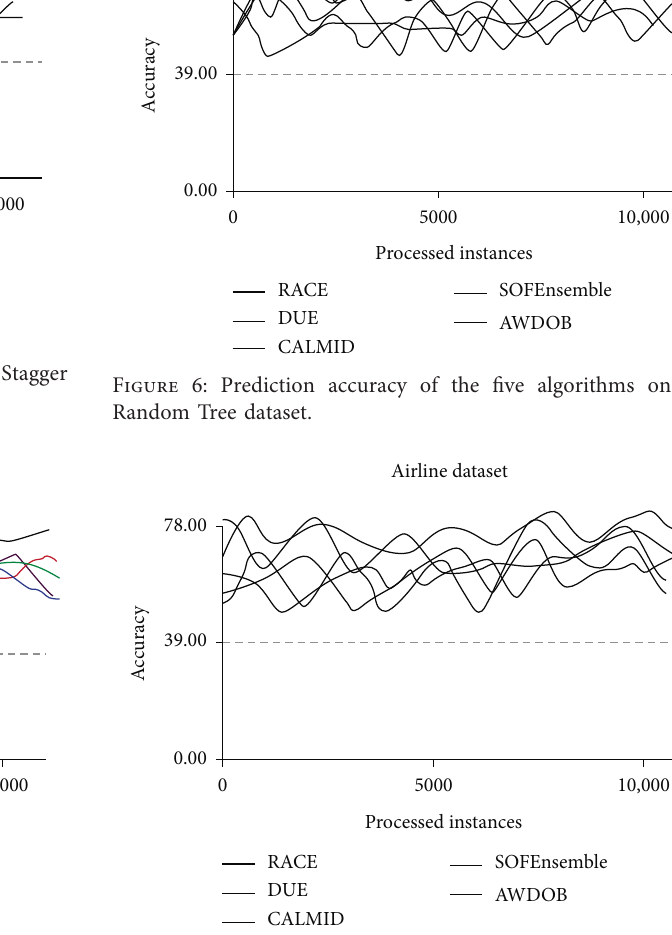
Figure 4: Prediction accuracy of the five algorithms on the LED dataset.